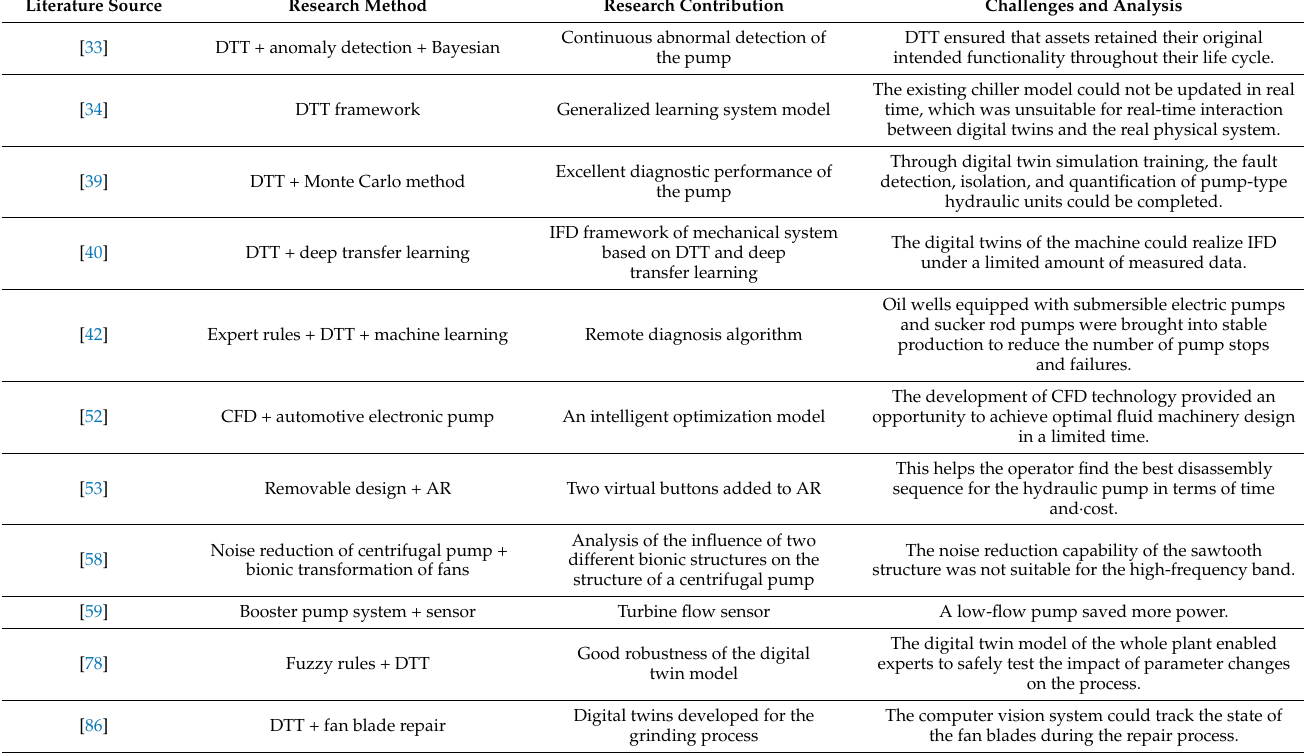
Table 1. Summary of the main research achievements in digital twins in fluid